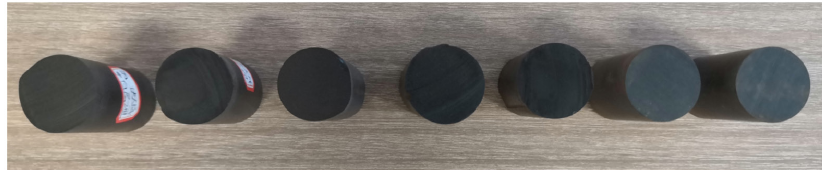
Fig. 2. Oil shale samples (size: ∅ 25 × 50